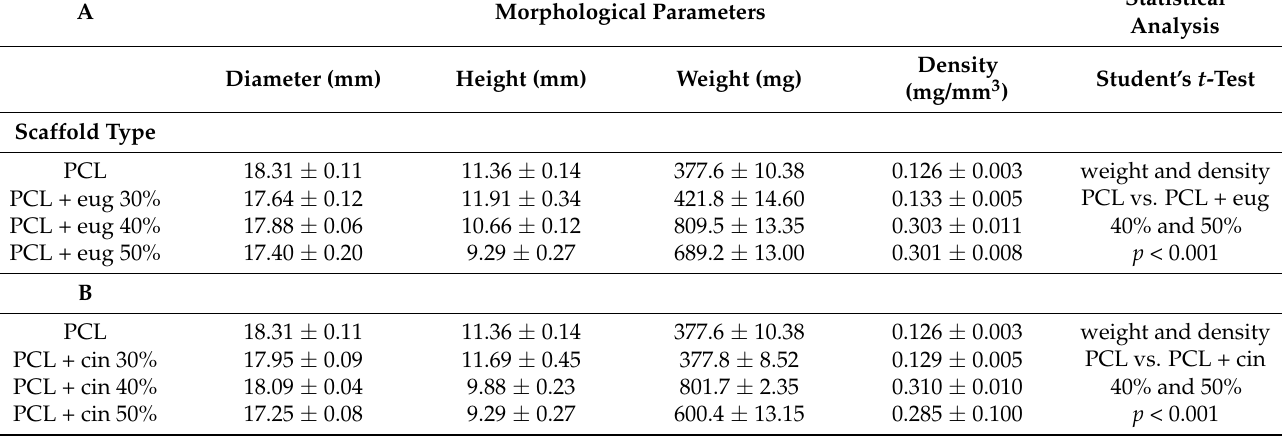
Table 1. Morphological characteristics (reported as mean ± standard error of the mean) of the PCL-based scaffolds (obtained with NaCl) added with increasing (from 30 to 50%) concentrations of eugenol ( A ) or cinnamon oil ( B